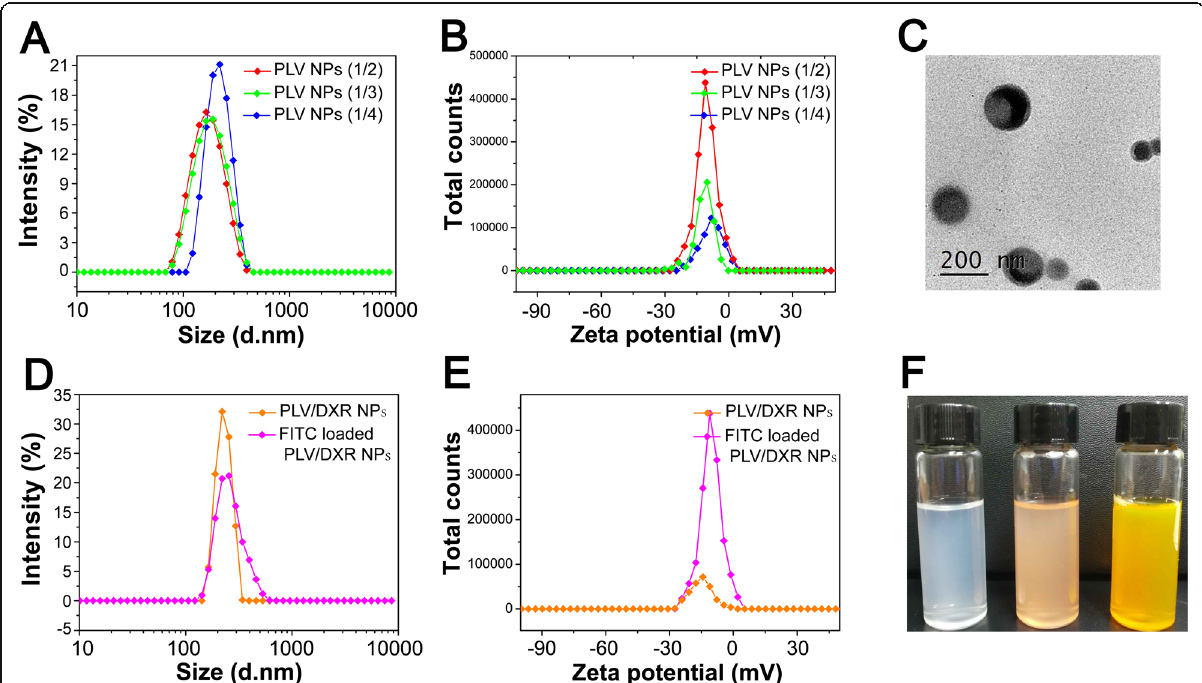
Fig. 4 Characterization of nanoparticles (NPs). a Particle size and distribution of PLV. b Zeta potential of PLV. c Transmission electron microscopy image of PLV (1/2). d Particle size and distribution of PLV/DXR and FITC-loaded PLV/DXR. e Zeta potential of PLV/DXR and FITC-loaded PLV/DXR.